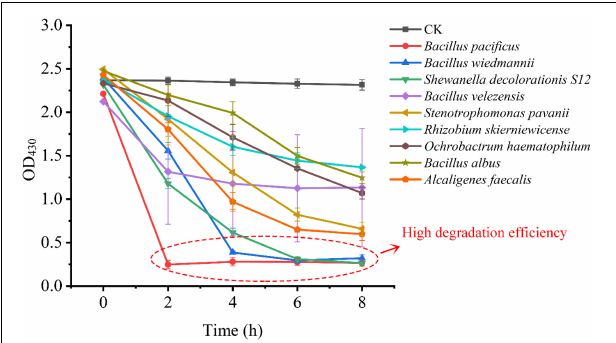
FIGURE 5 | Verification of azo decolorization function of sorted